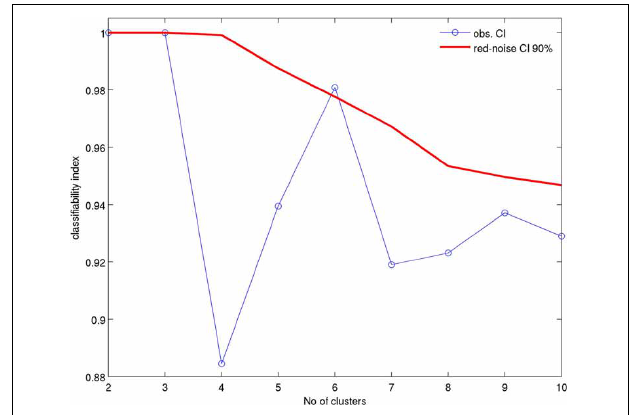
FIGURE 1 | Classifiability index CI (Michelangeli et al., 1995) of the k -means, with k = 2 to 10 clusters, for the clustering of zonal and meridional daily 850hPa winds; the dataset is 242 days from September 1st to April 30st in the 34 seasons from 1979–80 to 2012–13. The zonal and meridional winds are standardized to zero mean and unit variance and the k -means clustering is applied to the 26 leading principal components (PCs) that capture at least 75% of the entire variance. The red solid line is the one-sided 90% significance level from 100 red-noise